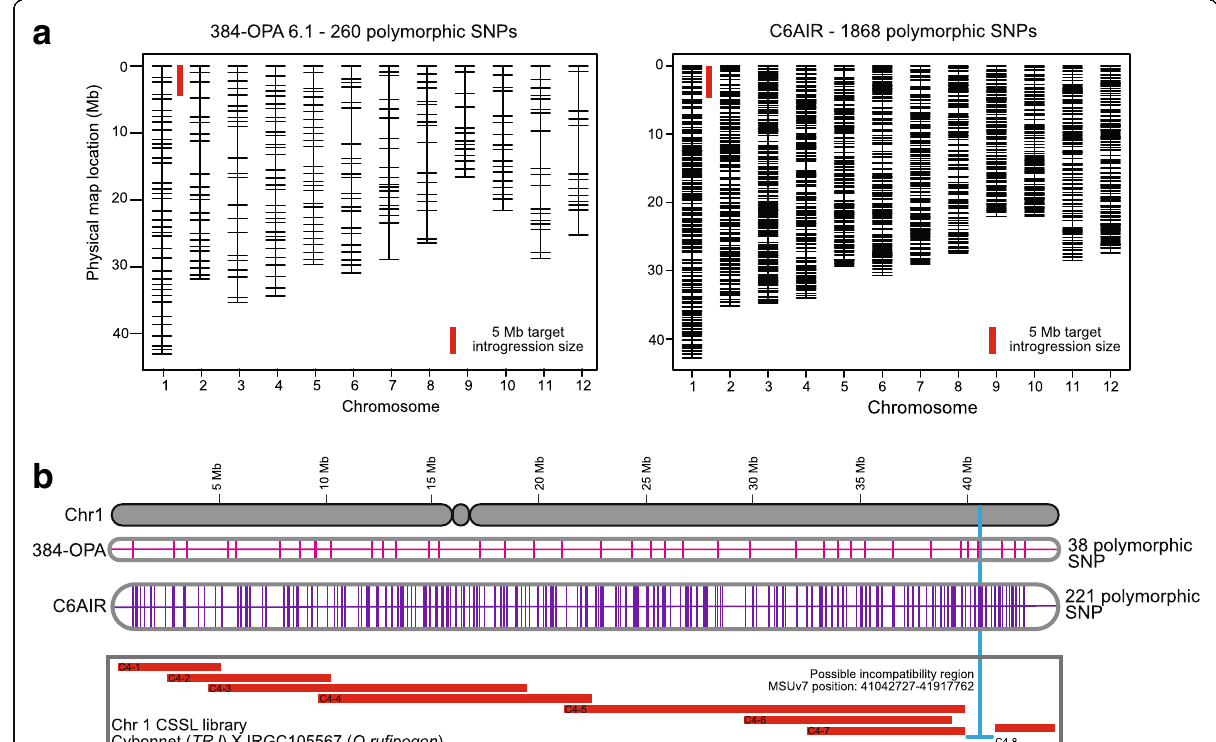
Fig. 6 Comparison of the use of 384-SNP Golden Gate assay (OPA 6.1) and C6AIR genotyping platforms for foreground and background selection. CSSLs were developed between the elite tropical japonica variety Cybonnet as the recurrent parent, and O. rufipogon , IRGC105567, as the donor parent. a Distribution of 260 informative SNPs across 12 rice chromosomes detected using the 384-SNP assay (OPA 6.1) (left) and 1868 polymorphic SNPs using the C6AIR (right). The red bar indicates 5 Mb target introgression from the donor parent in the background of Cybonnet. Using the 384-OPA, an average 5 Mb region harbors ~1 – 3 informative SNPs; using the C6AIR, a 5 Mb region harbors ~5 – 8 informative SNPs. b Graphical representation of CSSL selection targeting overlapping introgressions on Chromosome 1 in the Cybonnet X IRGC105567 library using the 384-OPA 6.1 platform (38 polymorphic SNPs detected) (pink), and the C6AIR (221 polymorphic SNPs) (purple). Blue line indicates a region of putative incompatibility or